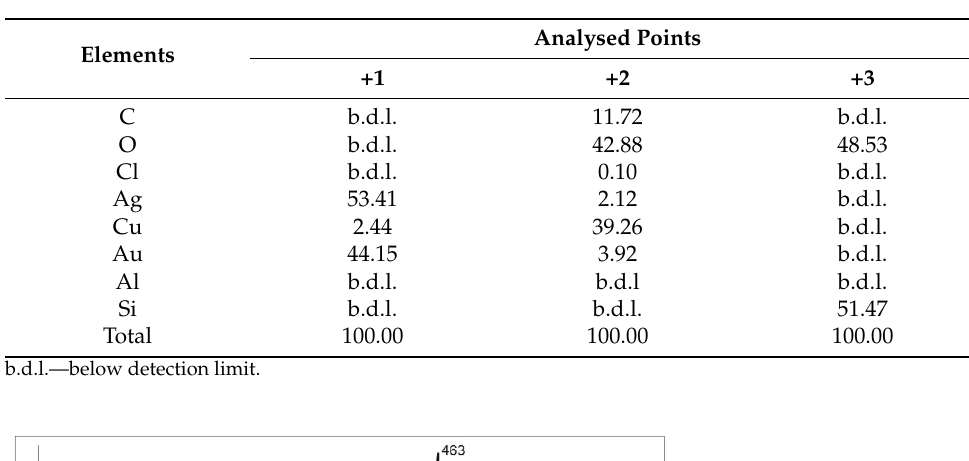
Figure 4. Backscattered electron (BSE) image of the cross. For chemical analyses obtained at the points numbered 1–3 see Table 1. Table 1. Chemical composition, in weight percentage, of the material and frame of the cross. For the exact position of the analysed points, see Figure 4.